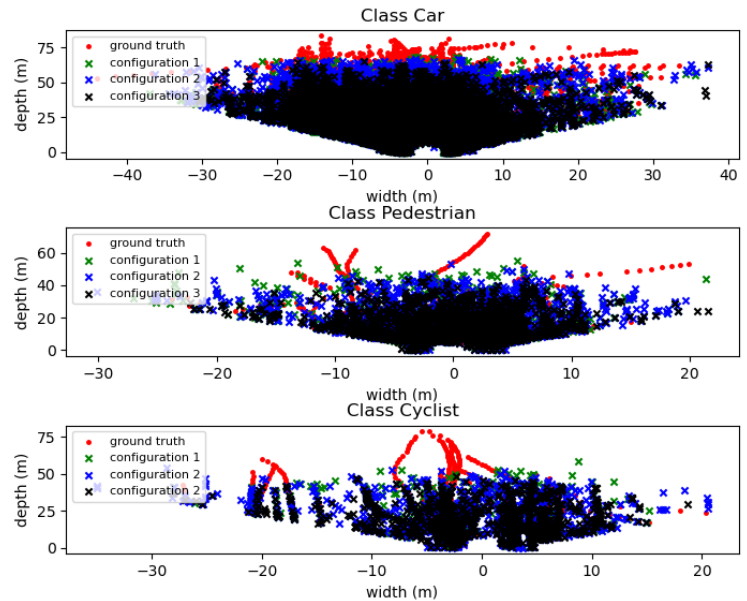
Figure 8. Representation of the location of the KITTI evaluation dataset’s ground truths and models predictions for all evaluation point clouds on a BEV perspective and according to the camera coordinate